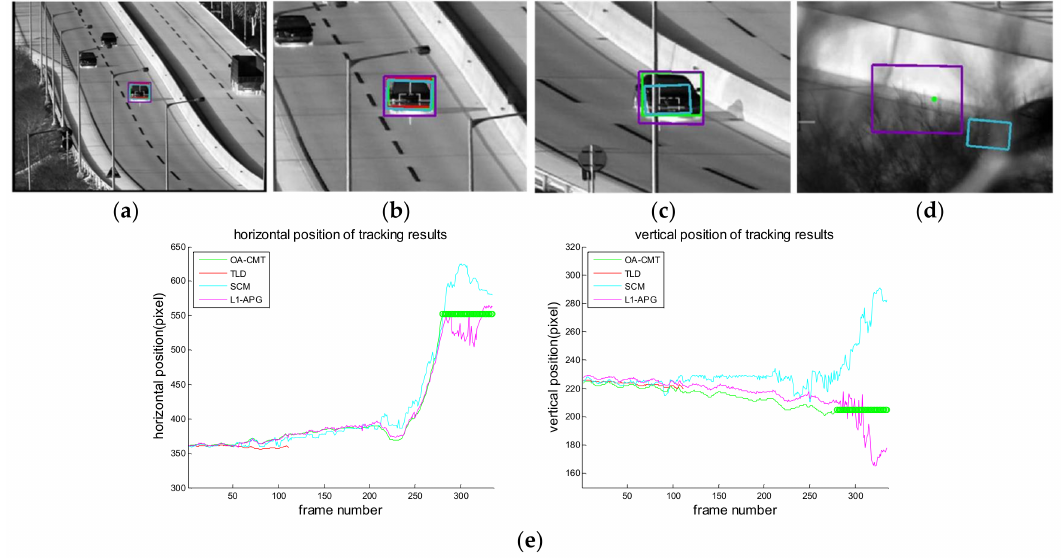
Figure 16. Computer simulation result of imagery ID 1. ( a ) Normal tracking status (original image); ( b ) magnifying interested area; ( c ) TLD loses track while the car is partially hidden by a street lamp; ( d ) OA-CMT turns to memory tracking status because the car is hidden by a bush; ( e ) tracking trajectories of each tracker. The green dot says OA-CMT turns to memory tracking status while other trackers are tracking the wrong position.